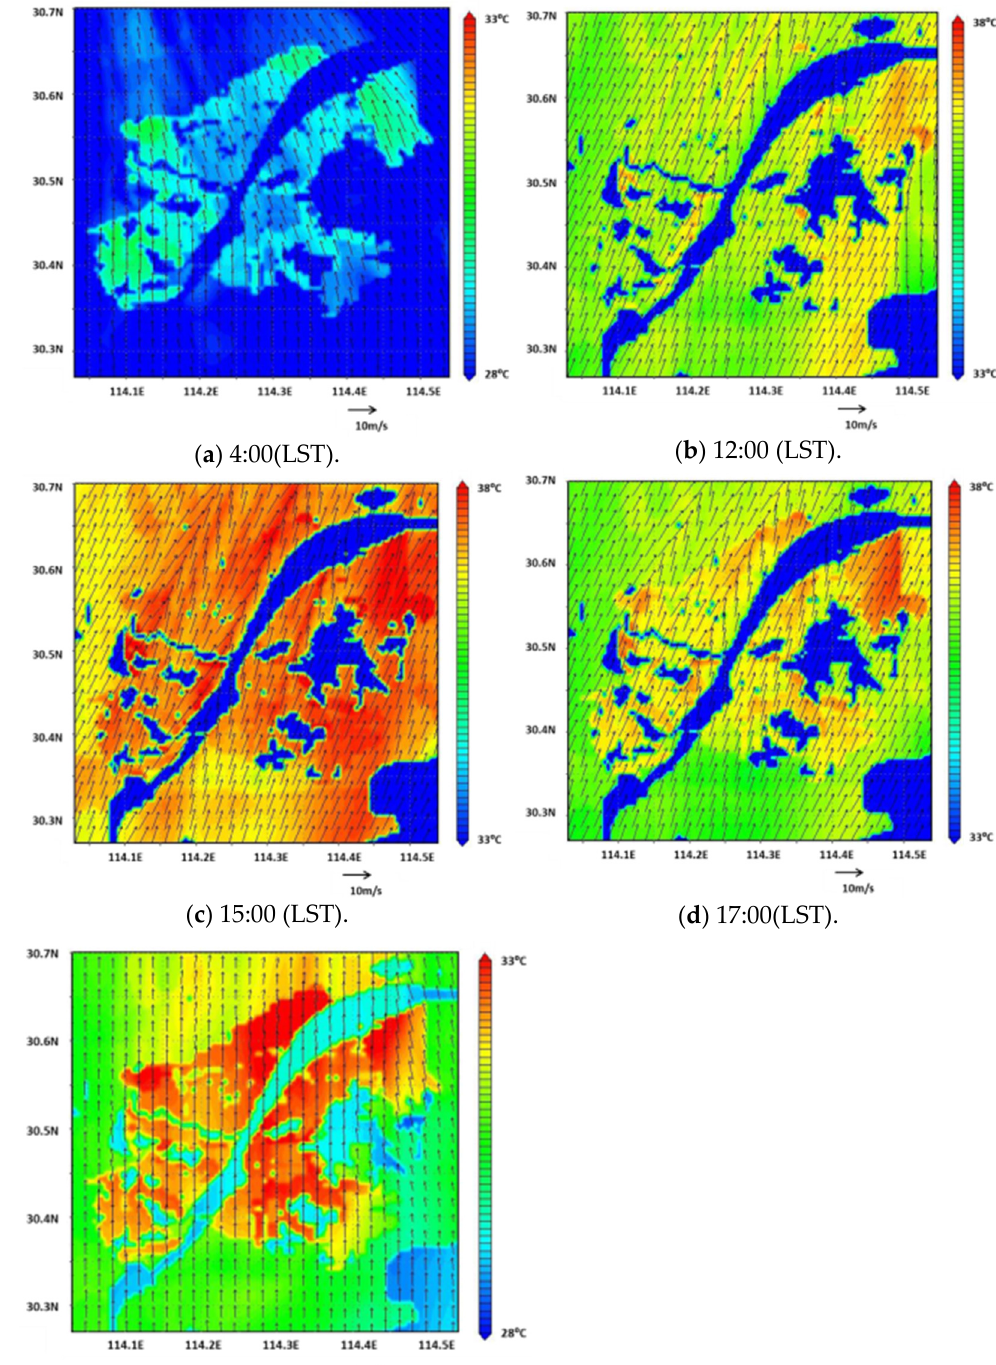
Figure 4. Air temperature and wind velocity of domain 3 on 31 July.